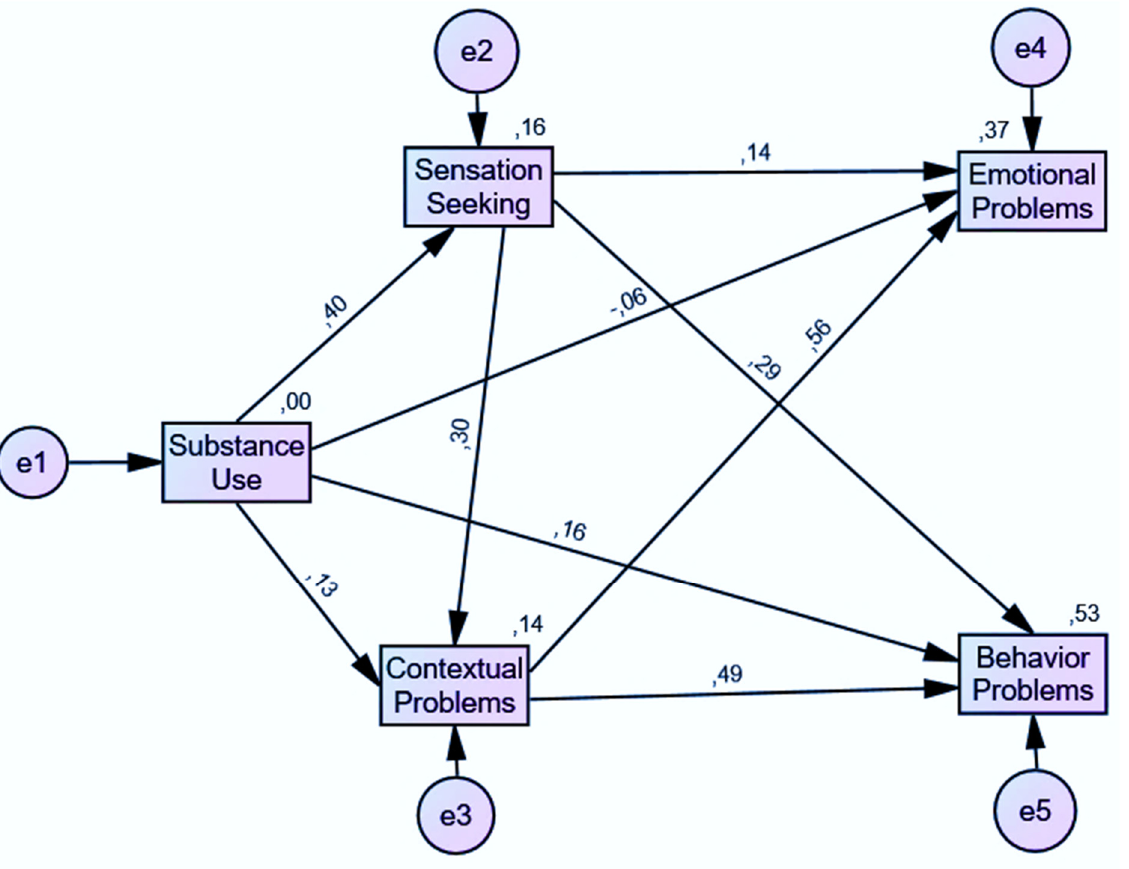
Figure 2. Path analysis model of substance use on emotional and behavior problems.